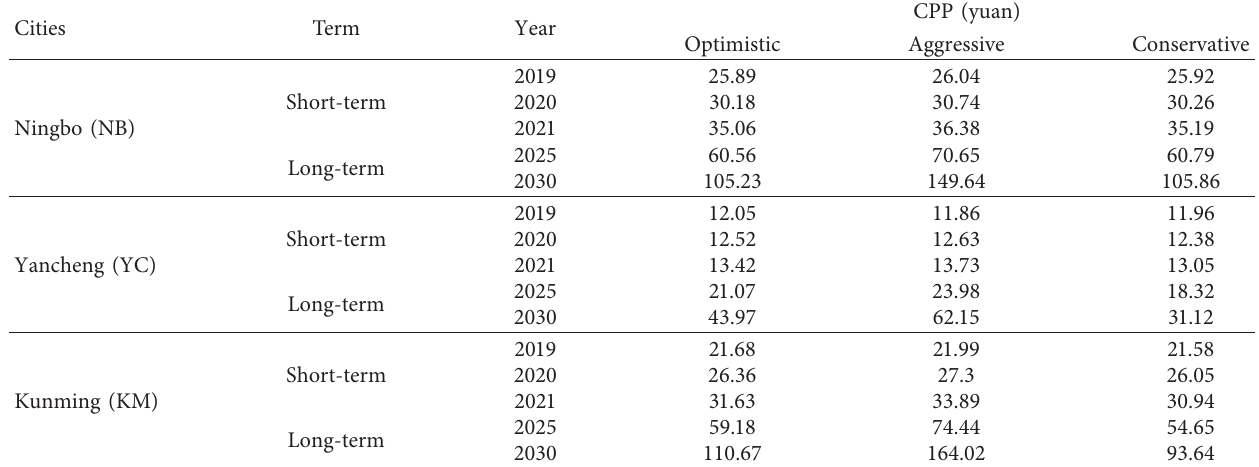
Table 14: CPP prediction results.